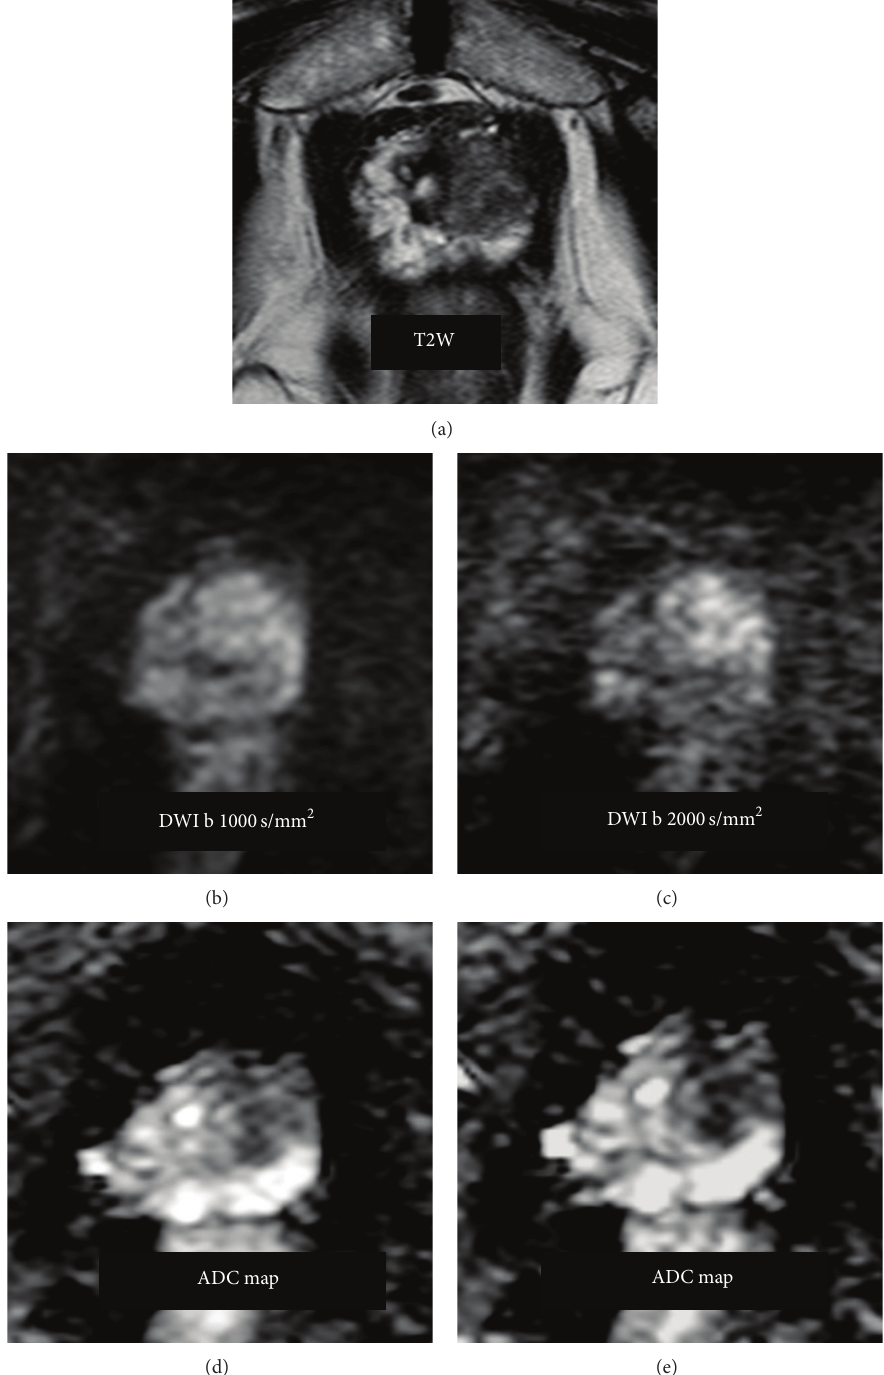
Figure 1: A 71-year-old man with prostate cancer Gleason 4 + 3. (a) T2-weighted image on the axial plane shows a hypointense focal area on left apex in the transitional zone. (b) DWI 𝑏 -value 1000 s/mm 2 shows a slight increased signal in the left transitional zone. (c) DWI 𝑏 -value 2000 s/mm 2 ; signal-to-noise ratio is decreased but signal intensity between the tumor and benign tissue is more evident. ((d) and (e)) ADC maps obtained with 𝑏 -values of 0–1000s/mm 2 (d) and 0–2000 s/mm 2 (e) show the tumor as a focal area of decreased signal intensity on the left apex in the transitional